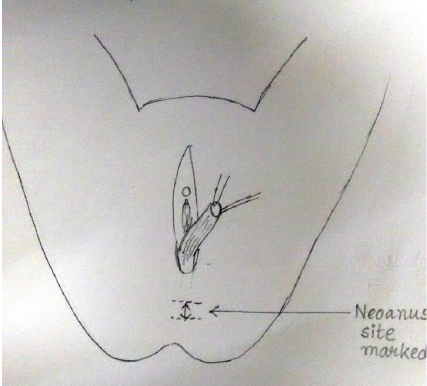
Figure 9: New anal opening marked with the help of muscle stimulator.